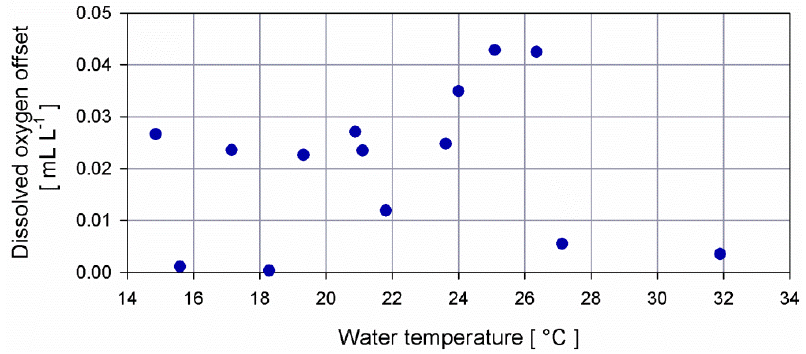
Figure 8. Absolute difference of dissolved oxygen measurements provided by the OPT positioned close to the inlet of the duct and the optode s/n 794 suspended at the outlet of the pump. Comparison between all SBE43 sensors and the OPT indicates a slight overestimation of all SBE43 independently from the type of membrane (for profiling or moored applications) although linearity is maintained. The root mean square error and the bias, calculated using Equation (1), show a misfit between the reference OPT and the SBE43 sensor of about 0.32 mL L −1 and 0.29 mL L −1 on average, respectively.